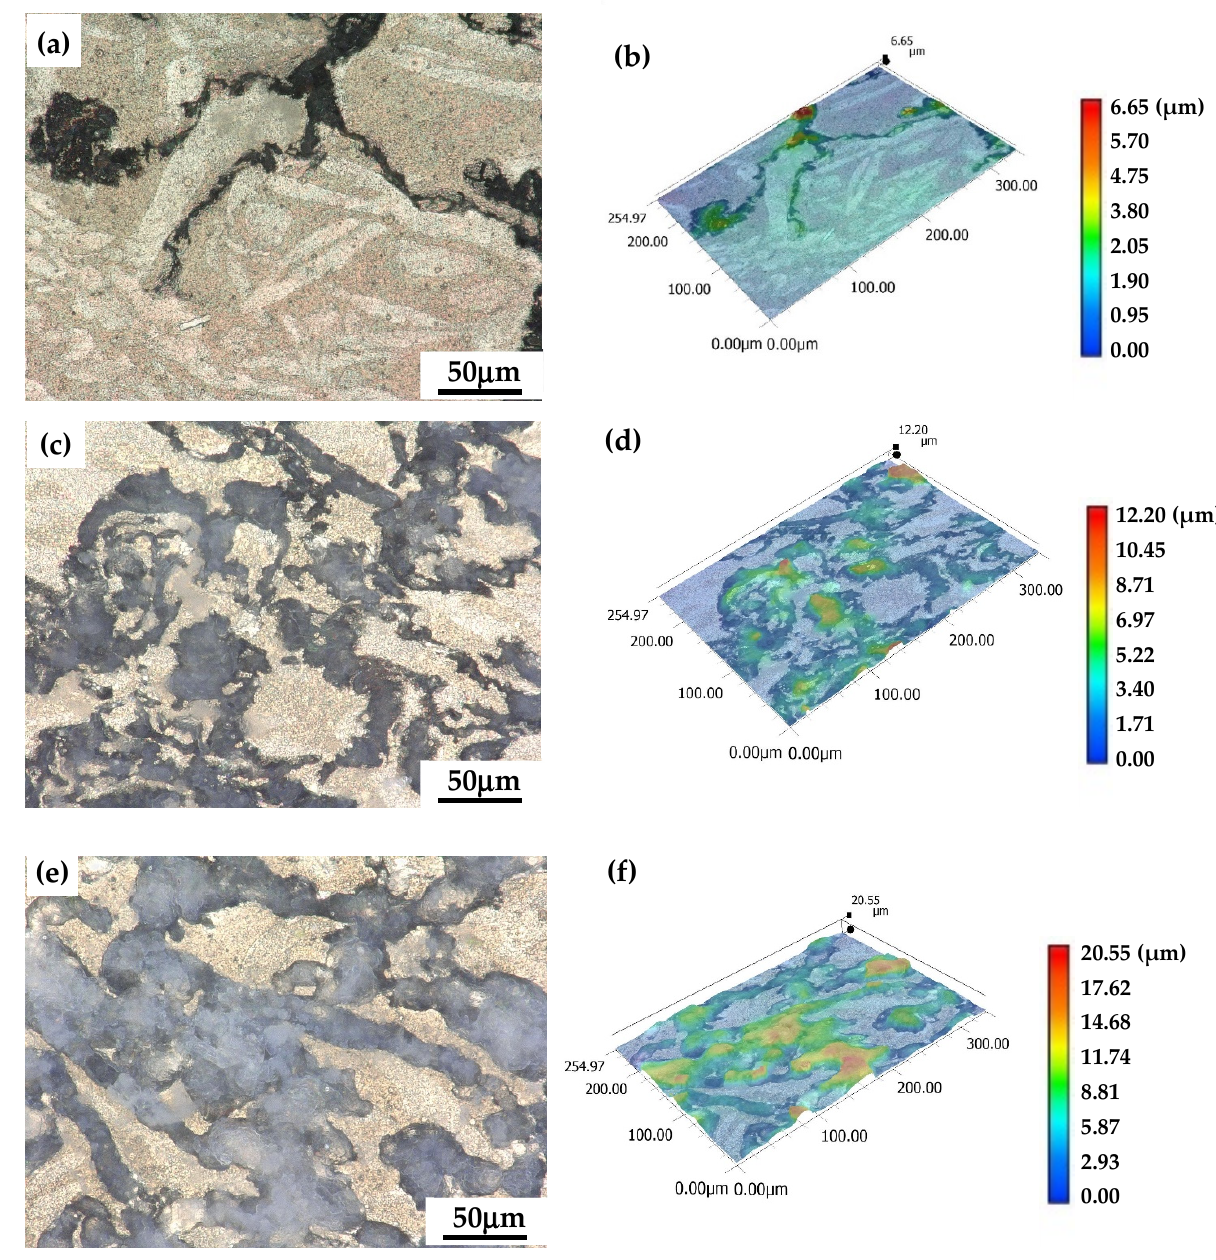
Figure 7. OM observations to the surface corrosion morphologies of the sample immersed in 0.9 wt.% solution for: ( a ) 4, ( c ) 8 and ( e ) 24 h. Images ( b ), ( d ) and ( f ) are 3D profiles of surface corrosion morphologies of samples immersed in 3.5 wt.% solution for 4, 8 and 24 h.